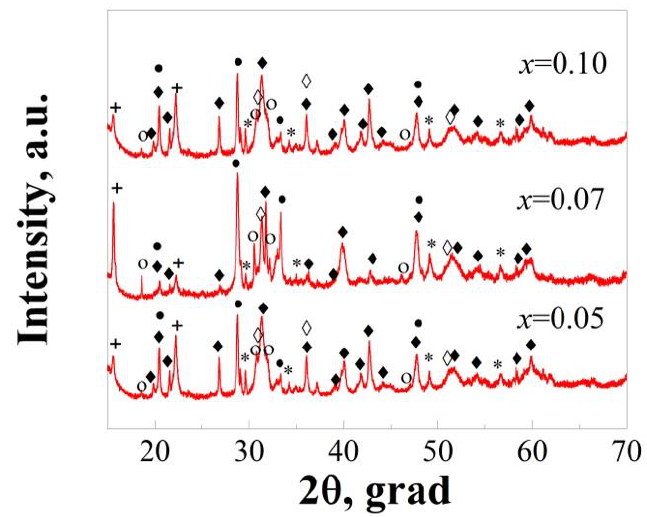
Figure 12. X-ray patterns of (1- x )Gd 2 Zr 2 O 7 · x MgO ceramics after exposure in LiCl-4 wt% Li 2 O melt at T = 650 ◦ C. Asterisks—Gd 2 Zr 2 O 7 , black diamonds—Li 2 ZrO 3 , black circles—Gd 2 O 3 , white diamonds—ZrO 2 , white circles—LiGdO 2 , crosses—LiGdCl 4 .